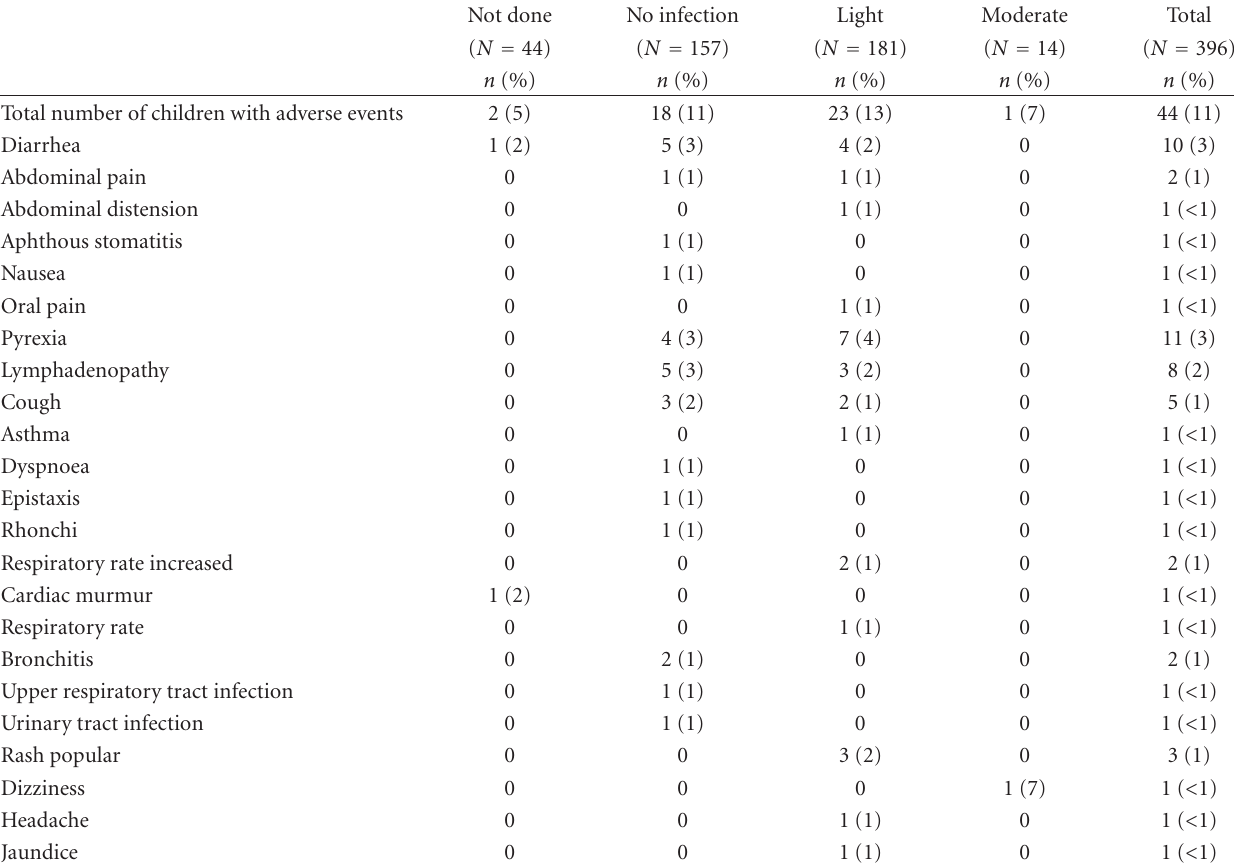
Table 4: TEAEs by intensity of helminth